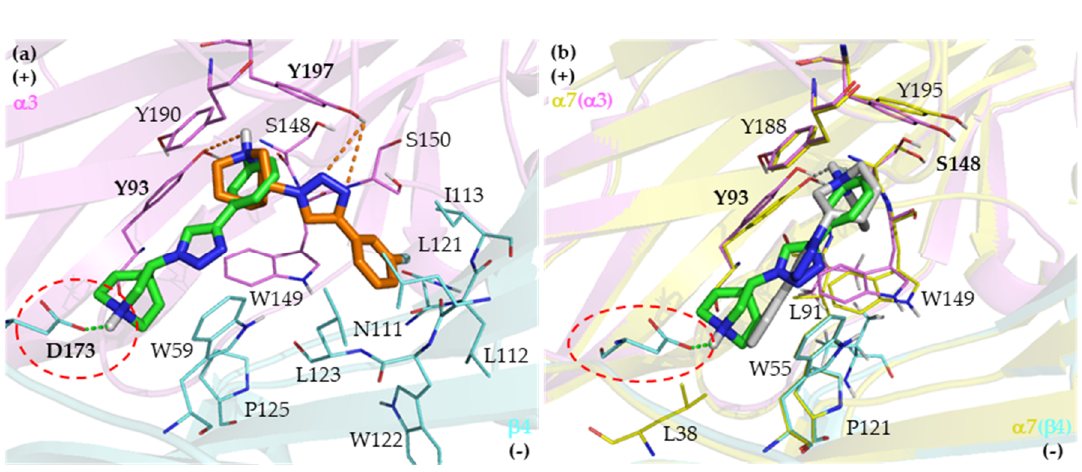
Figure 6. ( a ) The docking poses of ( R )-T2 (orange) and ( S )-T2 (green) showing the interacting residues with the α3β4 nAChR and ( b ) the overlay between the ( S )-T2 docking pose in the α3β4 (green) and the α7 nAChR (grey). The amino acid residues in Figure 6a represent the α3β4 homology model, whereas the amino acid residues in Figure 6b represent the α7 nAChR subunit. The bold letters show amino acids forming hydrogen bond interactions. The polar hydrogen atoms of the amino acid side chains are displayed to identify hydrogen bond donors and acceptors. Pink, α3 nAChR; cyan, β4 nAChR; yellow, α7 nAChR; red, oxygen; blue, nitrogen.